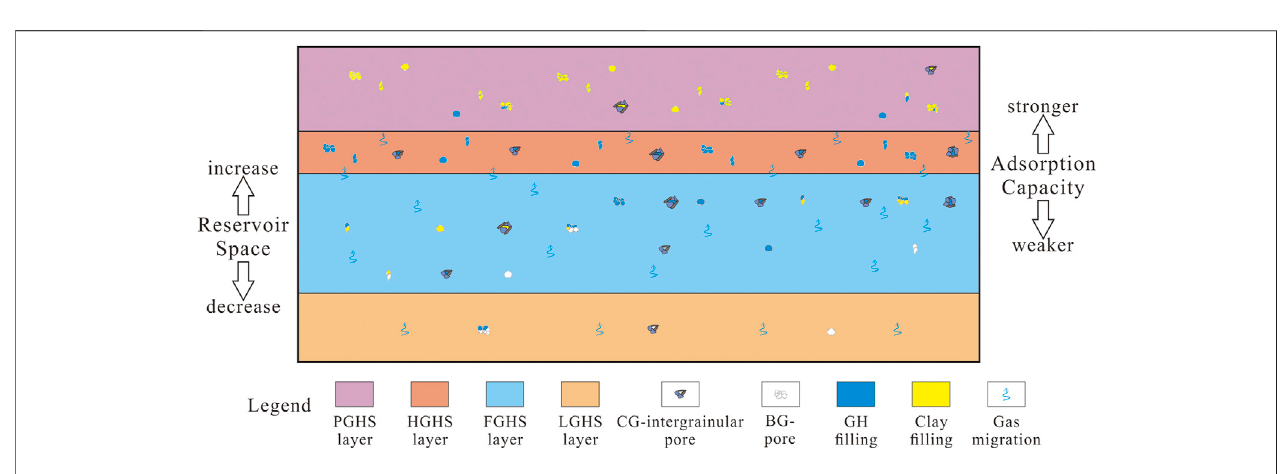
FIGURE 11 | Model of gas hydrate